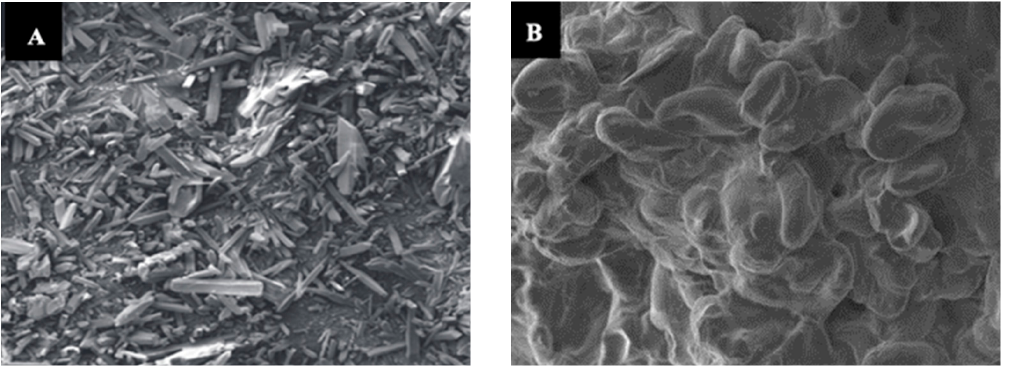
Figure 4. Surface morphology of uncoated urea ( A ) and rejected-sago-starch-coated urea ( B ).